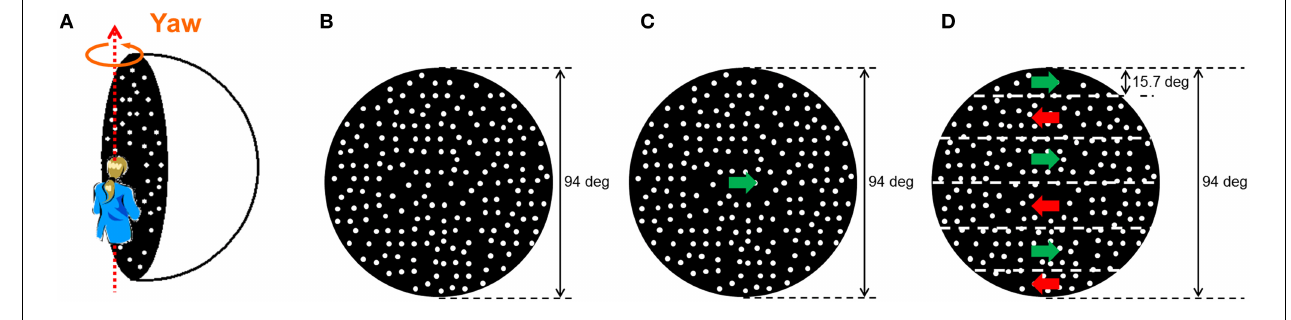
FIGURE 1 | Visual stimulus on the inside of the hemisphere screen. (A) The random dot pattern that was rotated along the yaw axis relative to the observer was projected onto the inside of a hemisphere screen. In this experiment, the participant sat in